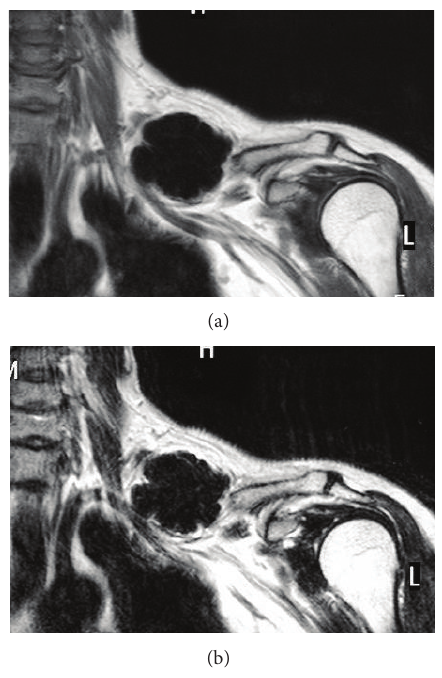
Figure 3: Magnetic resonance imaging reveals that the lesion has the same density as cortical bone. (a) A coronal T1-weighted image shows that the lesion has low signal intensity located in the midportion of the clavicle. (b) This coronal T2-weighted image shows the lesion with low signal intensity.